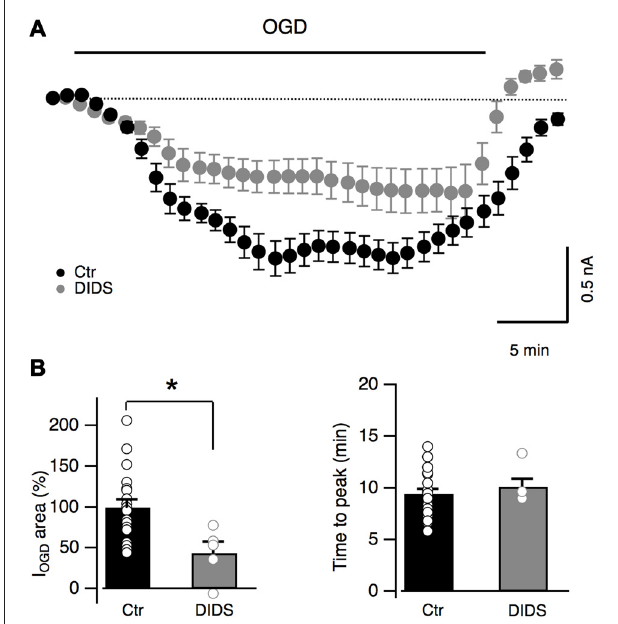
FIGURE 7 | DIDS partially blocks OGD-induced currents in Bergmann glia. (A) Average currents recorded during OGD with ( n = 7) or without ( n = 19) a non-specific blocker of anion channels DIDS (1 mM). (B) Average changes of I OGD area and time to peak in control ( n = 19) and in the presence of DIDS ( n = 5). P = 0.017 for I OGD area and P = 0.33 for I OGD time to peak. ∗ P < 0.05.